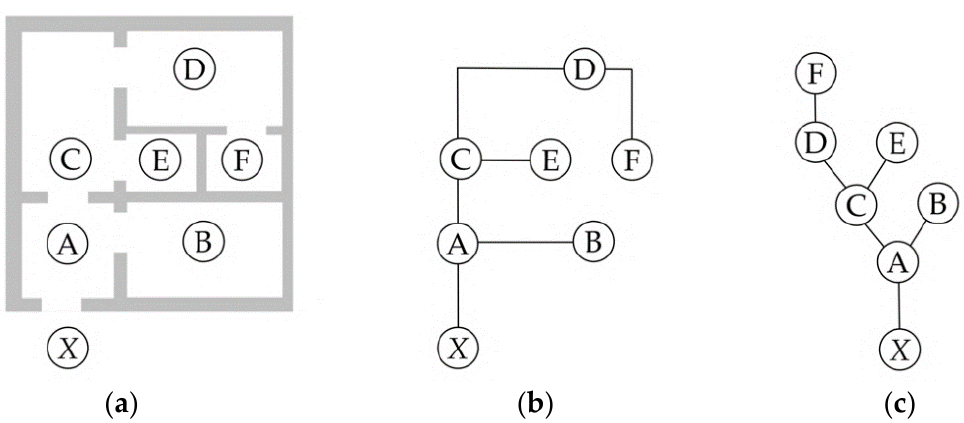
Figure 2. Example plan graph abstraction process: ( a ) an architectural plan with six rooms, annotated A–F and with the exterior ( X ) as carrier; ( b ) diagram of connections between spaces; ( c ) justified graph of the topology of the plan, relative to the exterior.